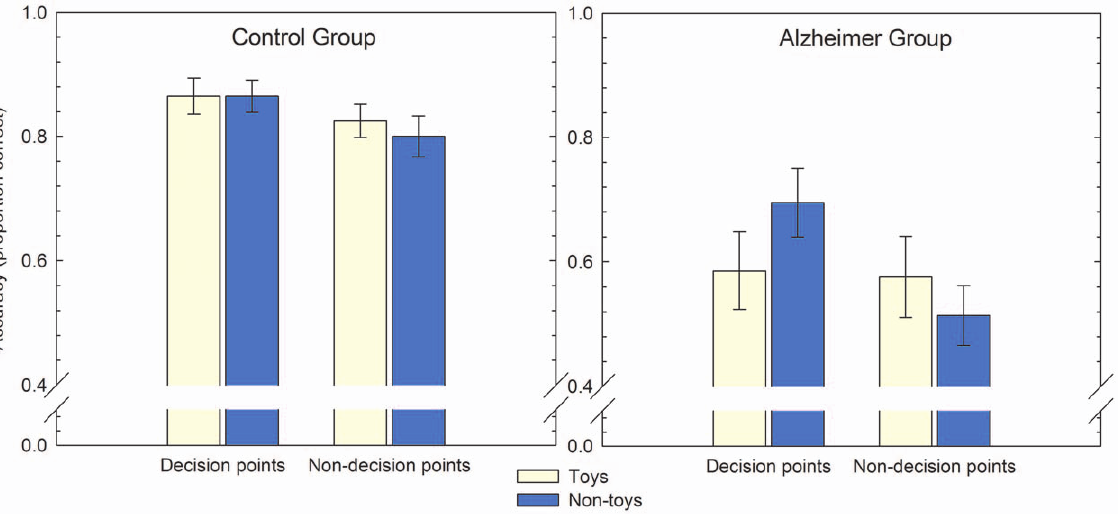
Figure 2. Recognition accuracy ( + S.E.M.) for the controls and the Alzheimer group for the toys and non-toys placed at decision points or non-decision points.